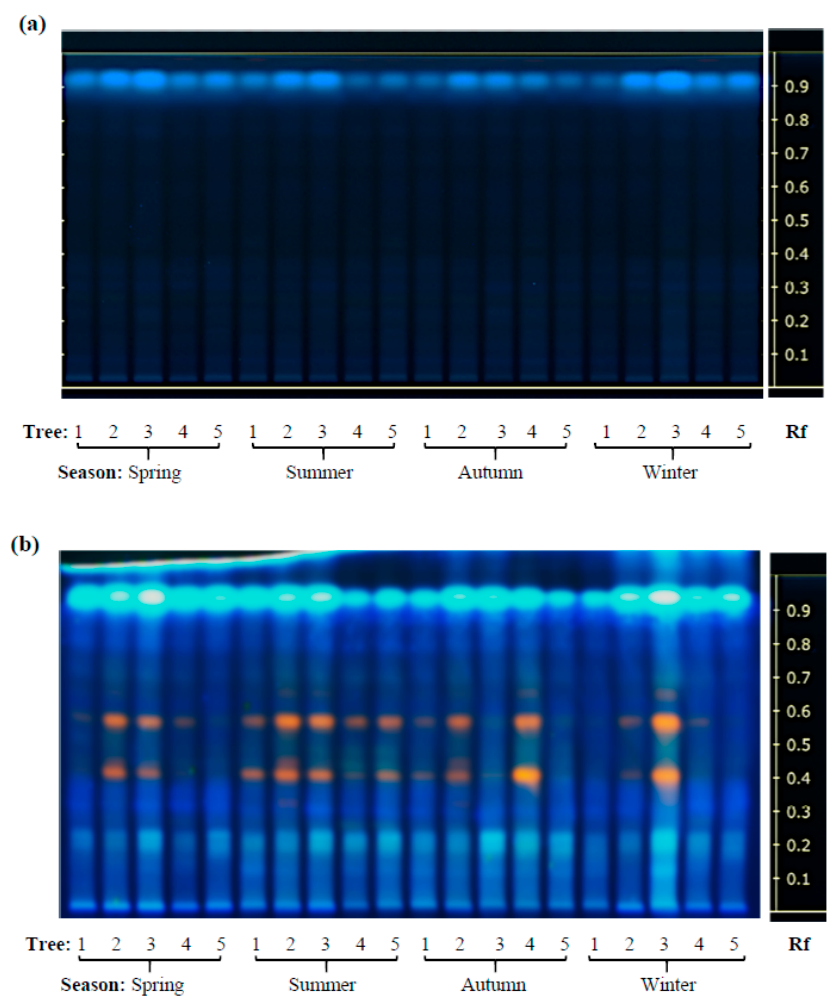
Figure 2. Seasonal variation in the content of phenolic secondary metabolites in Diospyros digyna . The HP-TLC traces of D. digyna leaf extracts visualized under ( a ) UV light (254 nm) and ( b ) UV light (366 nm) after derivatization with the NP / PEG reagent. Lanes: 1–5 represent leaf extracts from five trees (1–5) that were systematically sampled in the spring, summer, autumn, and winter of 2014. Band Rf values are represented on the right-side end of the figure.